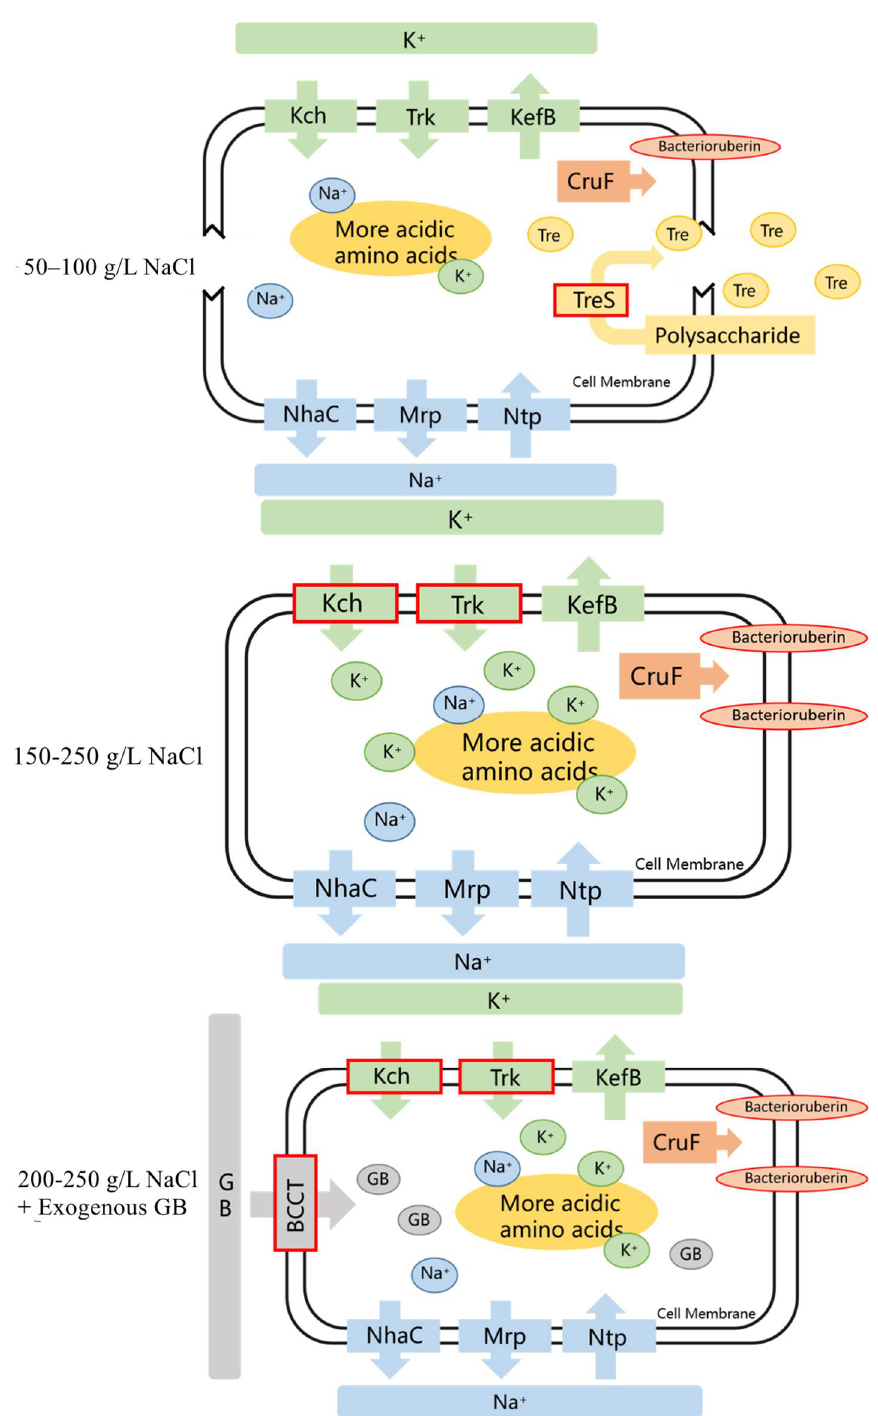
Figure 7. Overview of the halophilic mechanism of halophilic archaea H. kocurii 2020YC7. “GB” referred to glycine betaine and “Tre” referred to trehalsoe. “CruF” referred to carotenoid 1,2-hydratase.